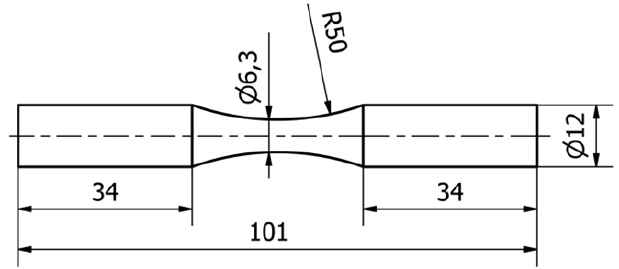
Figure 1. Specimen geometry and respective dimensions in [mm].